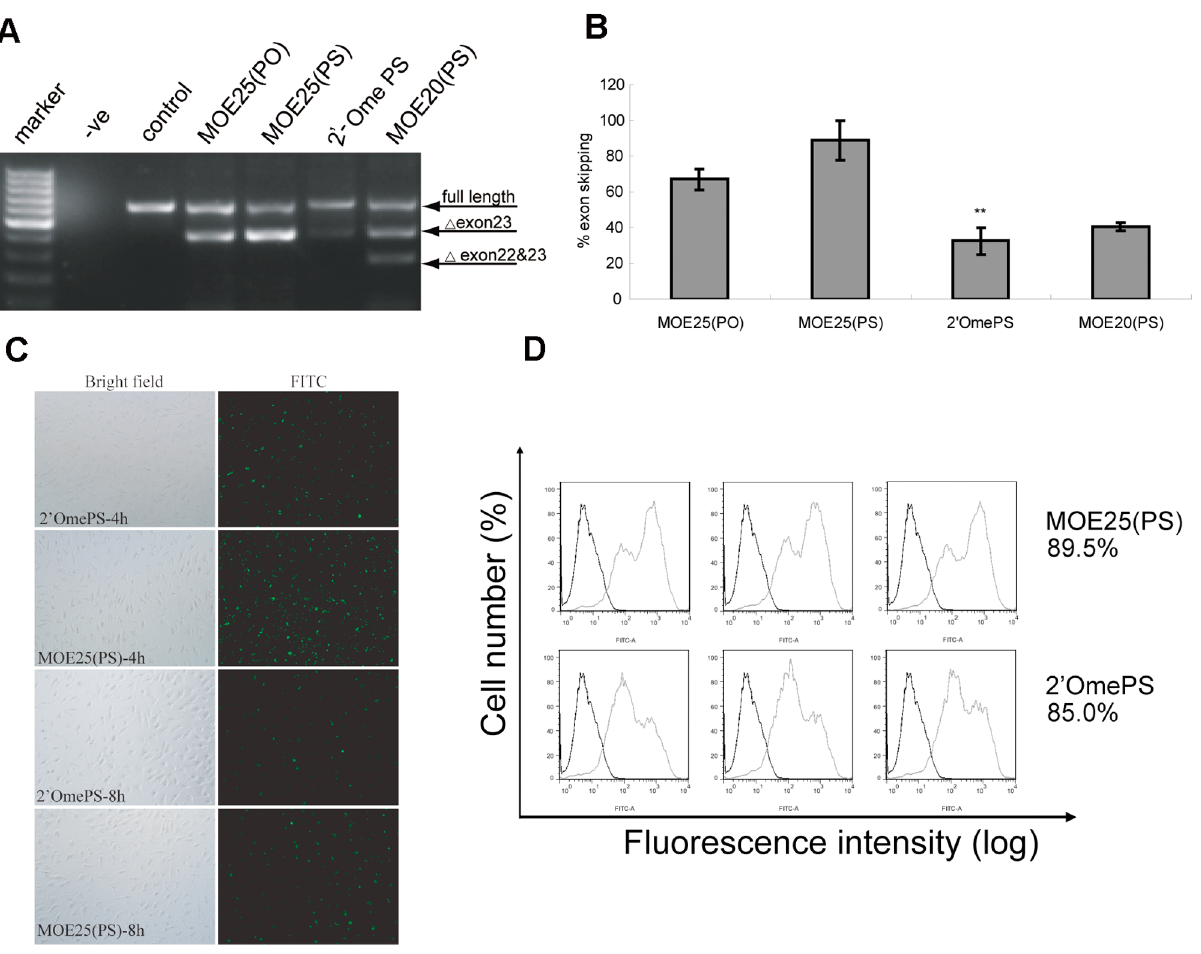
Figure 3. Direct comparison between MOE and 2 9 OmePS AOs in inducing exon skipping in H 2 K mdx cells. (A) RT-PCR results for 500 nM MOE and 2 9 OmePS AOs in H 2 K mdx cells at 48 h after transfection. (B) Quantification of percentage of exon 23 skipping for MOE and 2 9 OmePS AOs at 48 h after transfection. The data indicate significant increased exon skipping was detected in cells treated with MOE25(PS) compared with 2 9 OmePS AOs (**p , 0.001). (C) Cellular uptake of fluorescence-labeled MOE25(PS) and 2 9 OmePS AOs in H2K mdx cells at the concentration of 500 nM. The cellular uptake was monitored 4 h and 8 h post-transfection with fluorescence microscopy and the data indicate higher uptake observed at 4 h time- point for both AOs. (D) Quantative analysis of the transfection efficiency with flow cytometry. The data show much stronger fluorescence intensity observed in cells treated with MOE25(PS) AOs than those treated with 2 9 OmePS AOs.